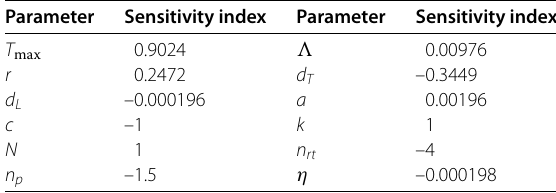
Table 12 Sensitivity indices for virus-free basic reproductive number R 0